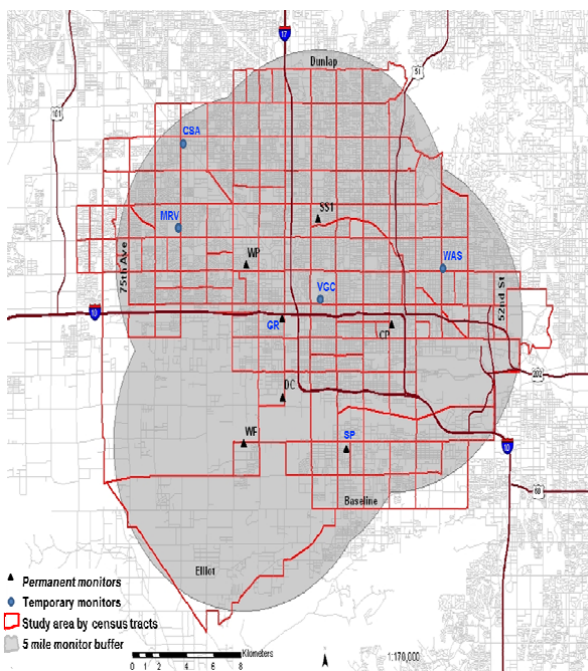
Fig. 2. Study domain and location of the monitors: permanent (data used in the health study) and temporary (data used for valida- tion of spatial interpolation method). Abbreviations: CP – Central Phoenix, DC – Durango complex, WF – West 43rd Avenue, WP – West Phoenix, SS1 – Supersite; GR – Greenwood; SP – South Phoenix; CSA – Community Service of AZ; MRV - Maryvale; VGC – Valley Garden Center; WAS – Weaver’s Auto